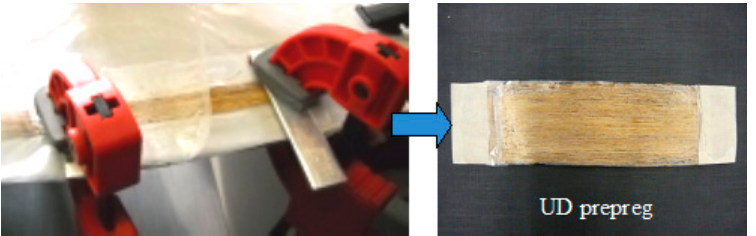
Figure 1. Preparation of UD coir fiber polypropylene prepreg.